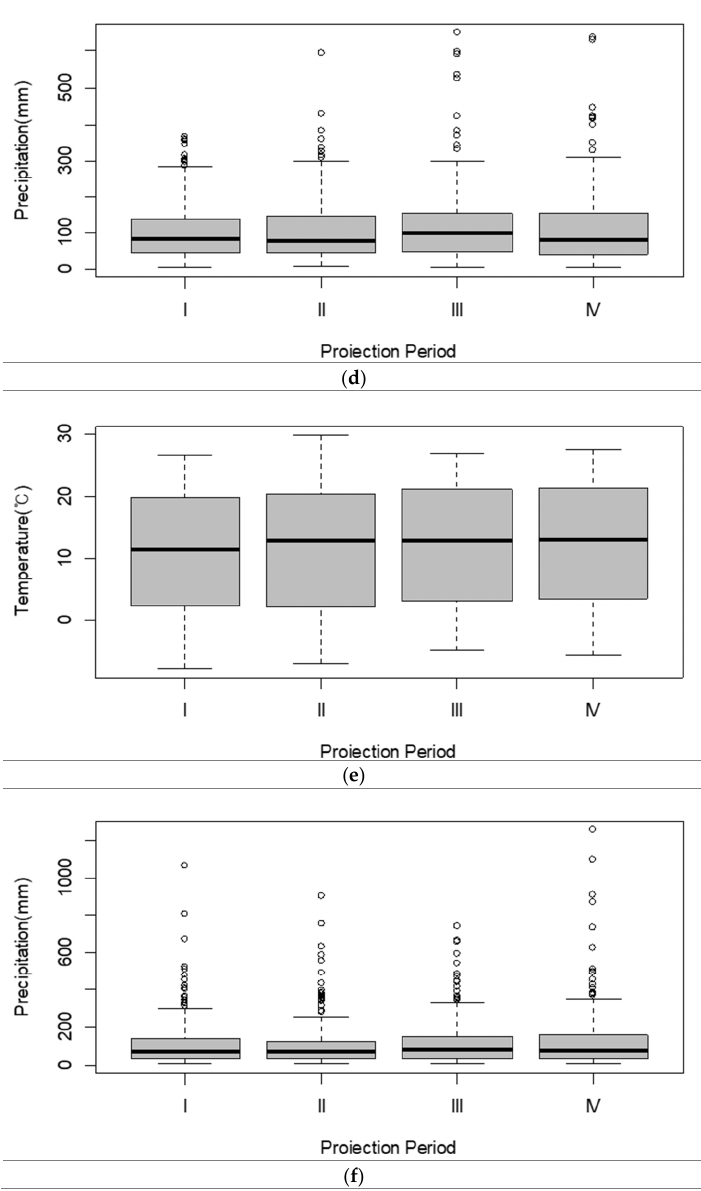
Figure 3. Changes in future monthly average temperatures and monthly precipitations. ( a ) Monthly average temperature (Jeongseon basin), ( b ) monthly precipitation (Jeongseon basin), ( c ) monthly average temperature (Saigokcheon junction basin), ( d ) monthly precipitation (Saigokcheon junction basin), ( e ) monthly average temperature (Socheon streamflow station basin), ( f ) monthly precipitation (Socheon streamflow station basin).